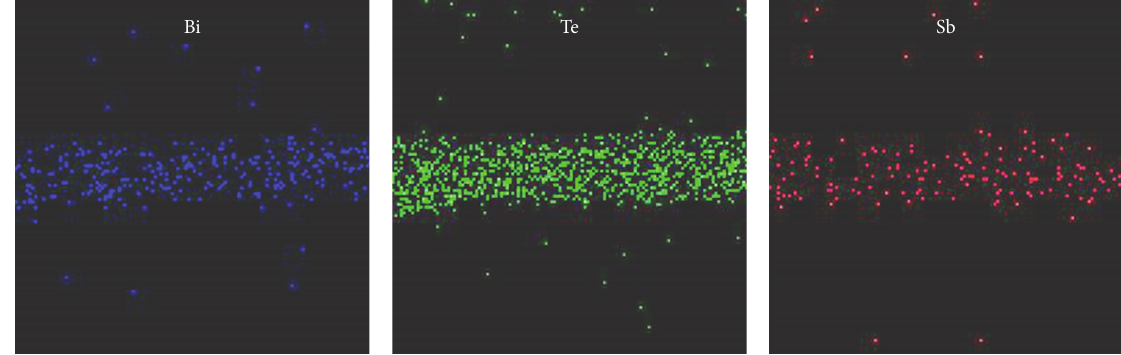
Figure 8: EDS analysis of the ( Bi , Sb ) 2−𝑥 Te 3+𝑥 -based